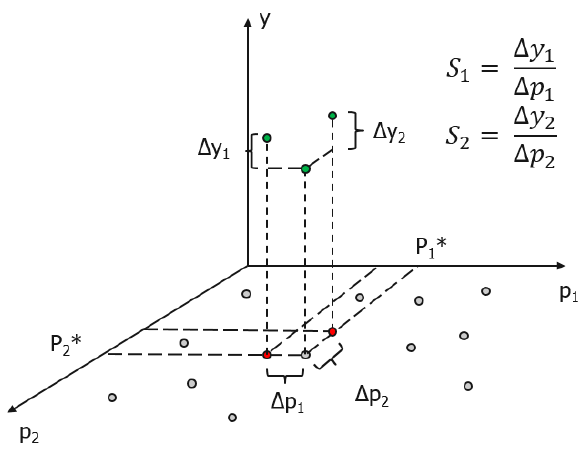
Figure 1. Graphical expression of Sensitivity Analysis.